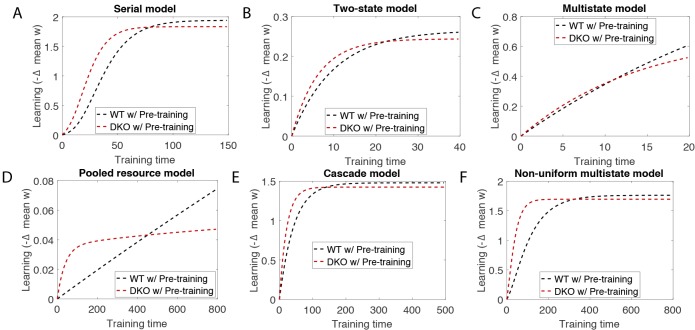
Simulation of training for long times after pre-training shows that it erases the effect of pre-training.These simulations were performed with the same parameters as in Appendix 1—table 1, but with much longer training times, for the (A) serial, (B) two-state, (C) multistate, (D) pooled resource, (E cascade and (F) non-uniform multistate models. Compare with Appendix 1—figure 2.